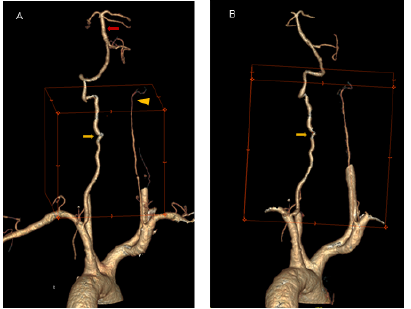
Figure 3. 3D reconstruction in the neutral head position and left-side head rotation. Panel ( A ): Coronal 3D reconstruction of the vertebral arteries in the neutral position of the head demonstrates L-VA loop in V2 segment at C4 level ( yellow arrow ) and R-VA hypoplasia ( yellow arrowhead ). No L-VA stenosis in this position. BA is formed exclusively by L-VA ( red arrow ). Panel ( B ): Coronal 3D reconstruction of the vertebral arteries in left-side head rotation demonstrates the narrowing of L-VA lumen (up to 2 mm × 3.2 mm) that causes a dynamic 60% L-VA stenosis in the loop at C4 level ( yellow arrow).